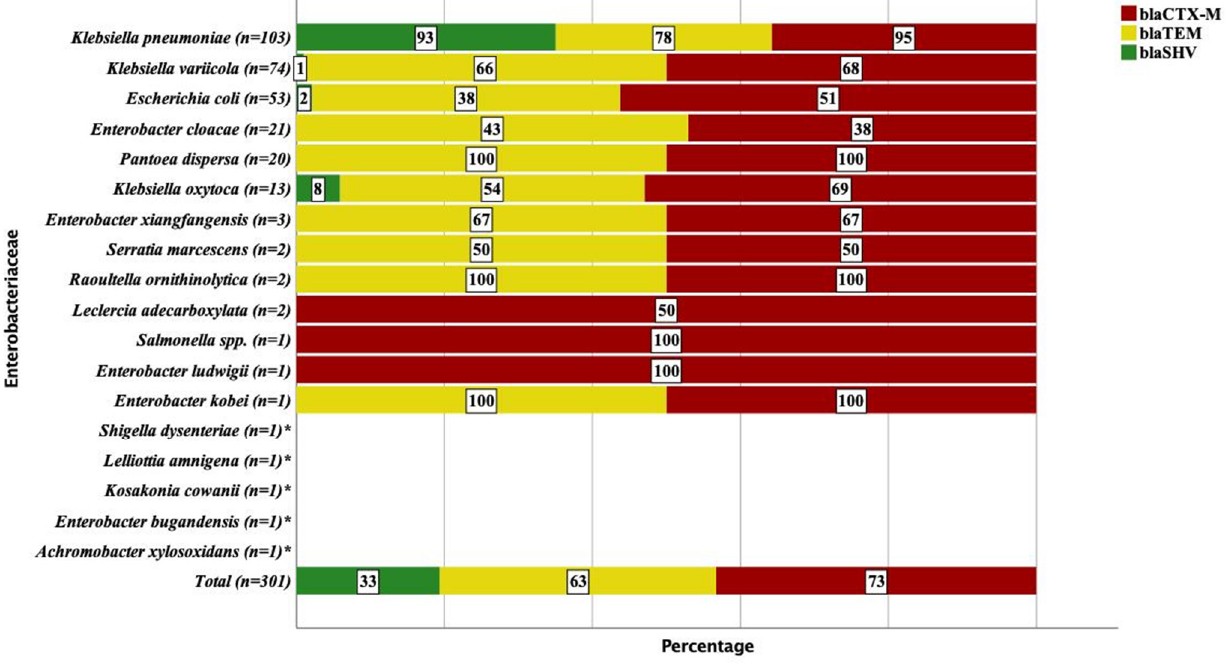
Table 3. Frequency of Enterobacteriaceae that harbored at least one ESBL gene in relation to patient characteristics.